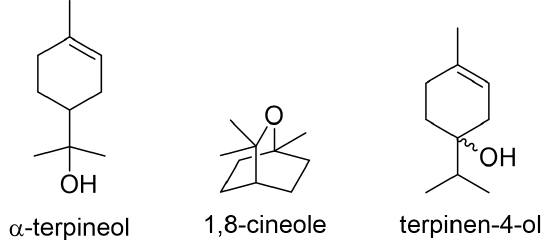
Figure 15. Main components of tea tree extract.